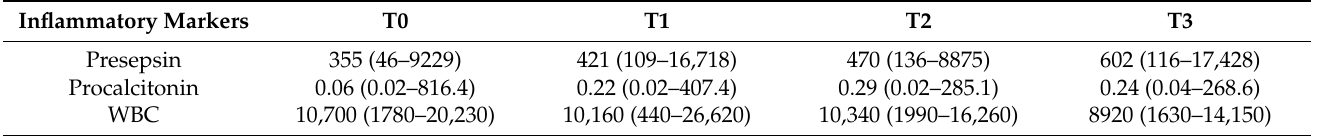
Table 4. Median values of inflammatory markers during observational period after surgery in total patients.